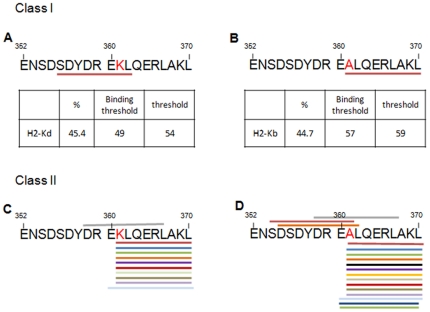
Analysis of the prediction of peptide-epitope binding to MHC class I and II molecules for WT and K409A M. leprae Hsp65, focusing in 352–370 amino acid region.Theoretical amino acid sequence identification of peptide-epitopes of the WT (A) and K409A (B) Hsp65 and the homology percentage of consensus peptide binders to MHC H2 alleles. Primary structure identification of peptide-epitopes of the WT (C) and K409A (D) binding to mice and human MHC class II molecules.